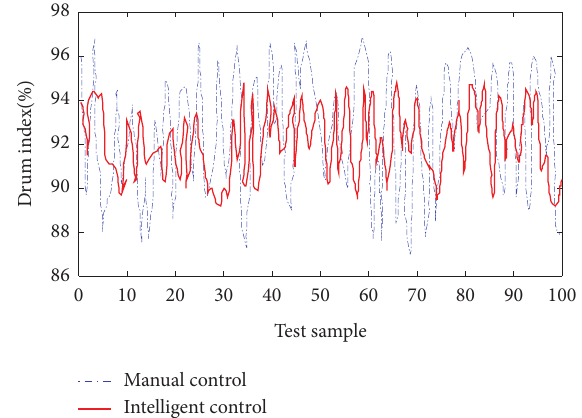
Figure 10: Comparison of rational energy drum index of finished pellets.